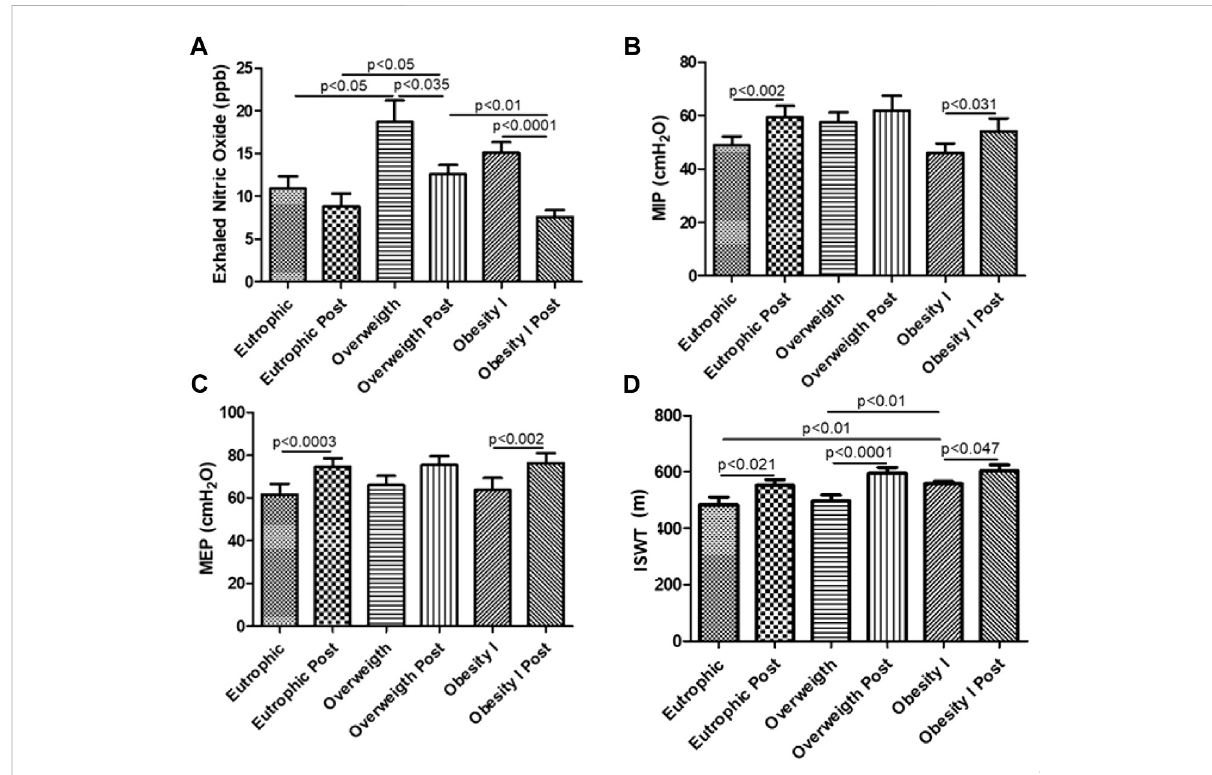
FIGURE 2 Effects of combined training on the levels of FeNO, MIP, MEP, and ISWT. Figure 2A shows the levels of fractional exhaled nitric oxide (FeNO). Figure 2B shows the maximum inspiratory pressure (MIP). Figure 2C shows the maximum expiratory pressure (MEP). Figure 2D shows the distance reached inISWT. Paired t -testwasperformedto comparethepre- and post-effects of rehabilitation (i.e., eutrophic non-obese pre xeutrophic non- obese post; overweight pre x overweight post; obesity I pre x obesity I post). A p < 0.05 was considered statistically signi fi cant. These data presented parametric distribution and were additionally evaluated using one way ANOVA followed by the Newman – Keuls test for multiple comparisons among the